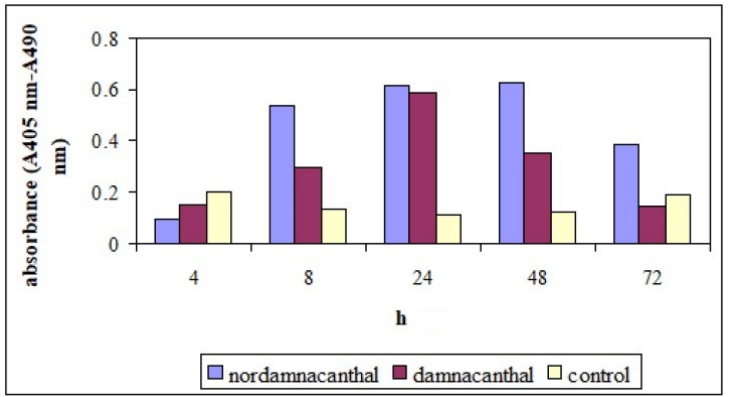
Figure 14. Detection of nucleosomes in cytoplasmic fractions of cell lysates at different hours of experiments. CEM-SS cells were treated with 30 μg/mL of indicated compounds. Control cultures were not treated with nordamnacanthal or damnacanthal. 20 μL of cell lysates were analyzed in the ELISA.